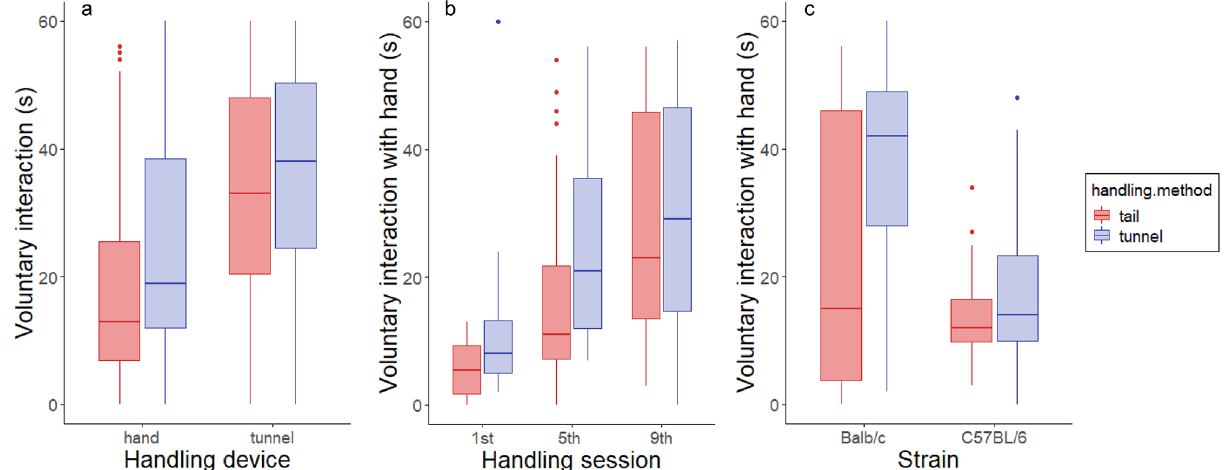
Figure 1. Voluntary interaction with both handling devices, experimenter’s hand and tunnel, when mice were handled daily for nine consecutive days. ( a ) Mice interacted with the tunnel more than with the experimenter’s hand. ( b ) Voluntary interaction with the experimenter’s hand increased across the three handling sessions for all mice. ( c ) Balb/c mice interacted more with the experimenter’s hand compared to C57BL/6 mice. Here, both interaction before and after handling are